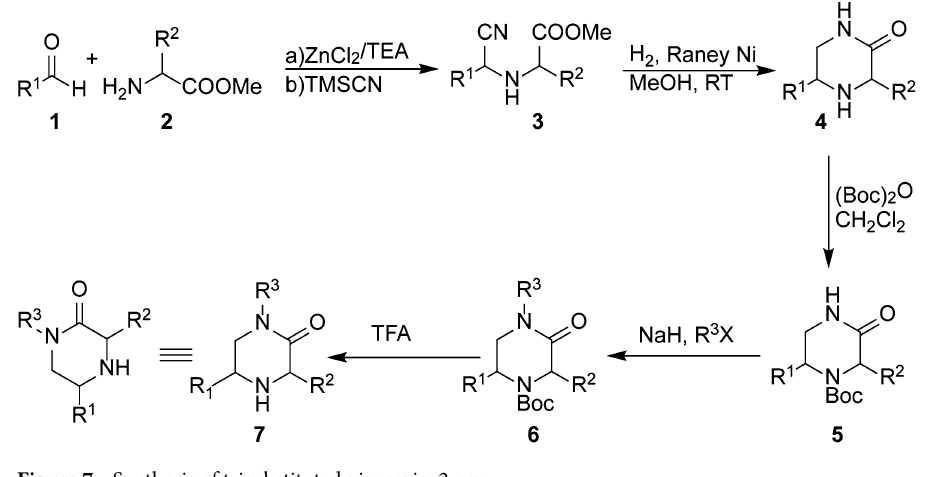
Figure 7. Synthesis of trisubstituted